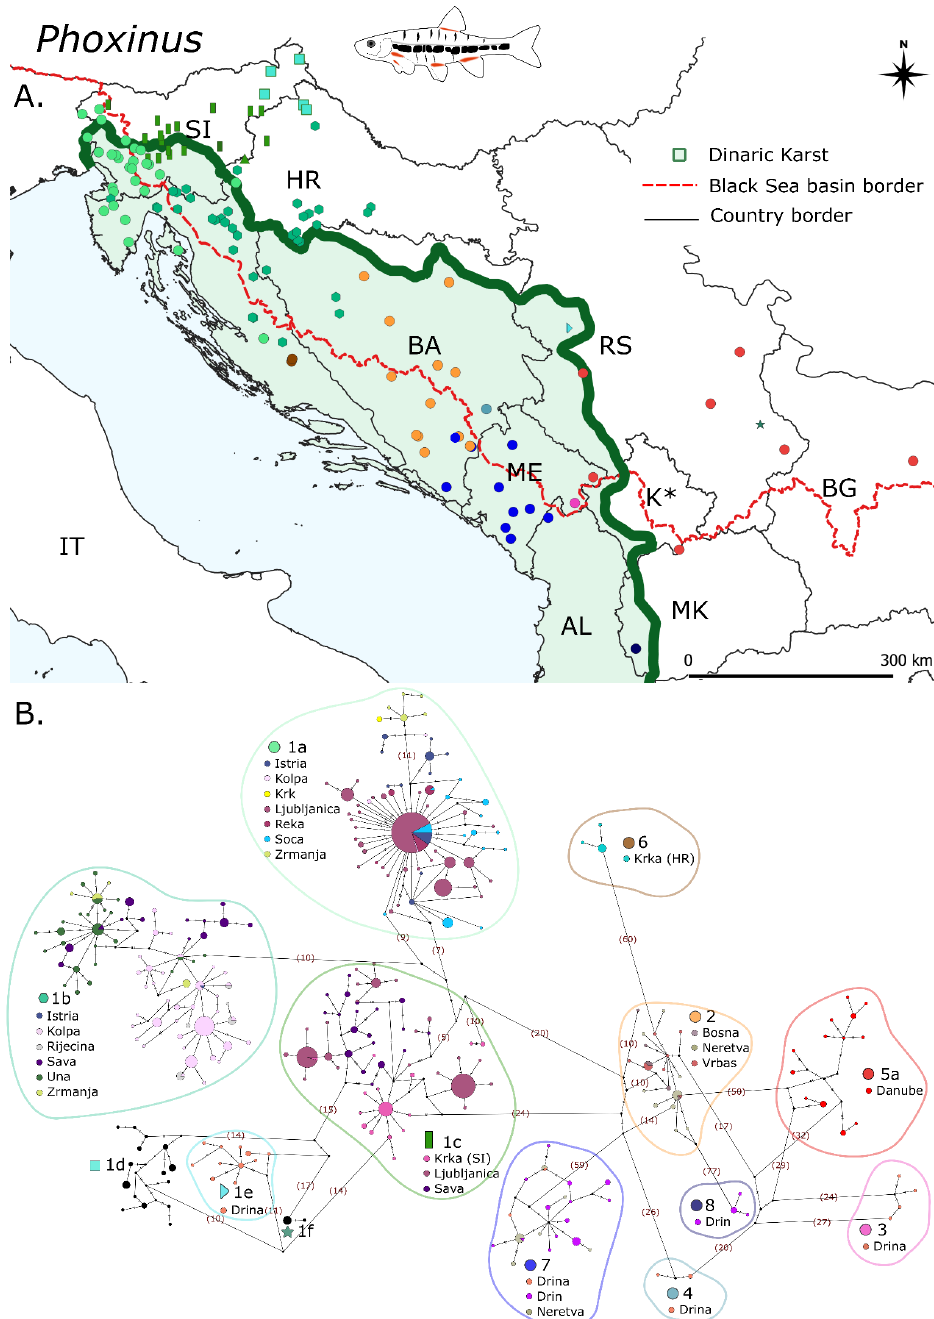
Figure 3. Distribution map and haplotype network (based on cytochrome b fragment) of Phoxinus mi- tochondrial (mt) lineages. The lineages are encoded following Palandaˇci´c et al. [37]. ( A ) Distribution of different mt (sub-)lineages of Phoxinus in Dinaric Karst and adjacent areas. Dinaric Karst is high- lighted in green; the Adriatic–Black Sea basin divide is marked with a red dashed line. ( B ) Haplotype network of the cytochrome b (cytb) marker. (Sub-)Lineages according to Palandaˇci´c et al. [37] are en- circled. Haplotypes are colored according to the river drainages in which they occur. River drainages are also written next to each mt (sub-)lineage. Mutational steps < 5 are given as dashes, mutational steps ≥ 5 are written in parentheses. Phoxinus mt sub-lineages 1d and 1f are represented in black, as they do not occur in Dinaric Karst (see A